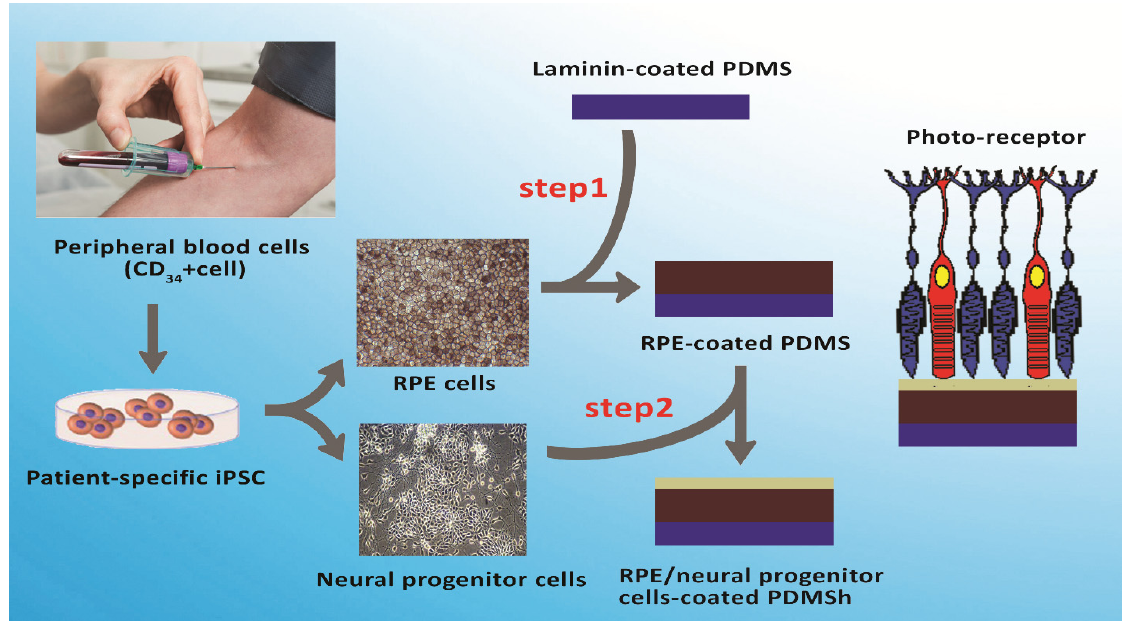
Figure 3. Process of pluripotent stem cells (iPSC) differentiation to photoreceptor and retinal pigment epithelium (RPE) trough bilayer-coating polydimethylsiloxane (PDMS)-PmL biomimetic film. Adapted with permission from [14]. Table 1. Nanomaterial scaffolds applied for ocular tissue engineering.